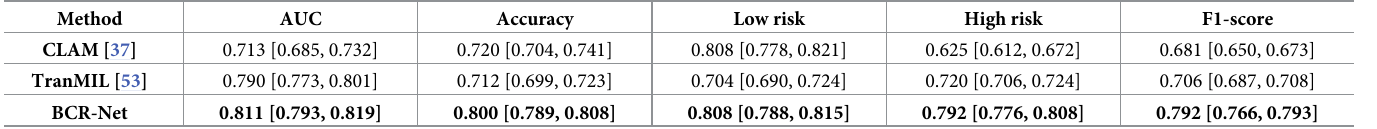
Table 3. Slide-level validation results of LTOCV on Ki67-stained slides. K = 3000 for BCR-Net results. Values are reported with mean and 95% CI (in []).